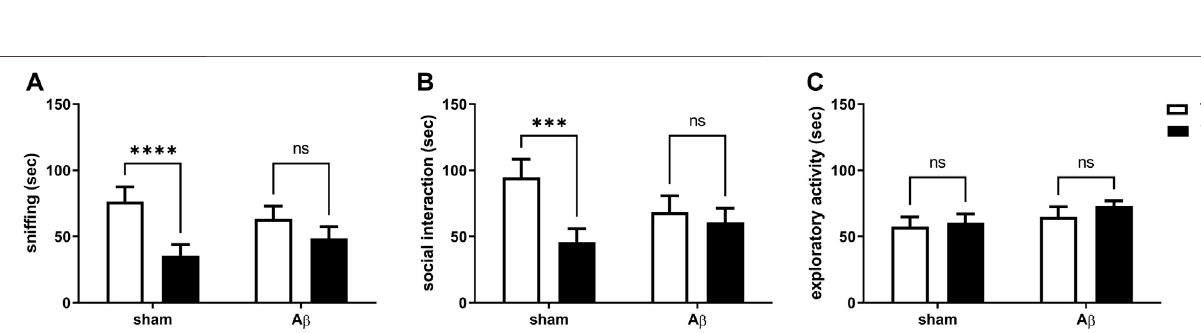
FIGURE 1 | Effects of A β administration on paw pressure and cold plate tests. (A) Tolerated weight (g) in sham (n (cid:1) 9) and A β -treated (n (cid:1) 7) animals. Two-way ANOVA for repeated measures followed by Š ídák ’ s multiple comparisons test, * p < 0.05 A β vs sham. (B) Licking latency (sec) in sham (n (cid:1) 10) and A β -treated (n (cid:1) 7) animals. Two-way ANOVA for repeated measures followed by Š ídák ’ s multiple comparisons test, p > 0.05.